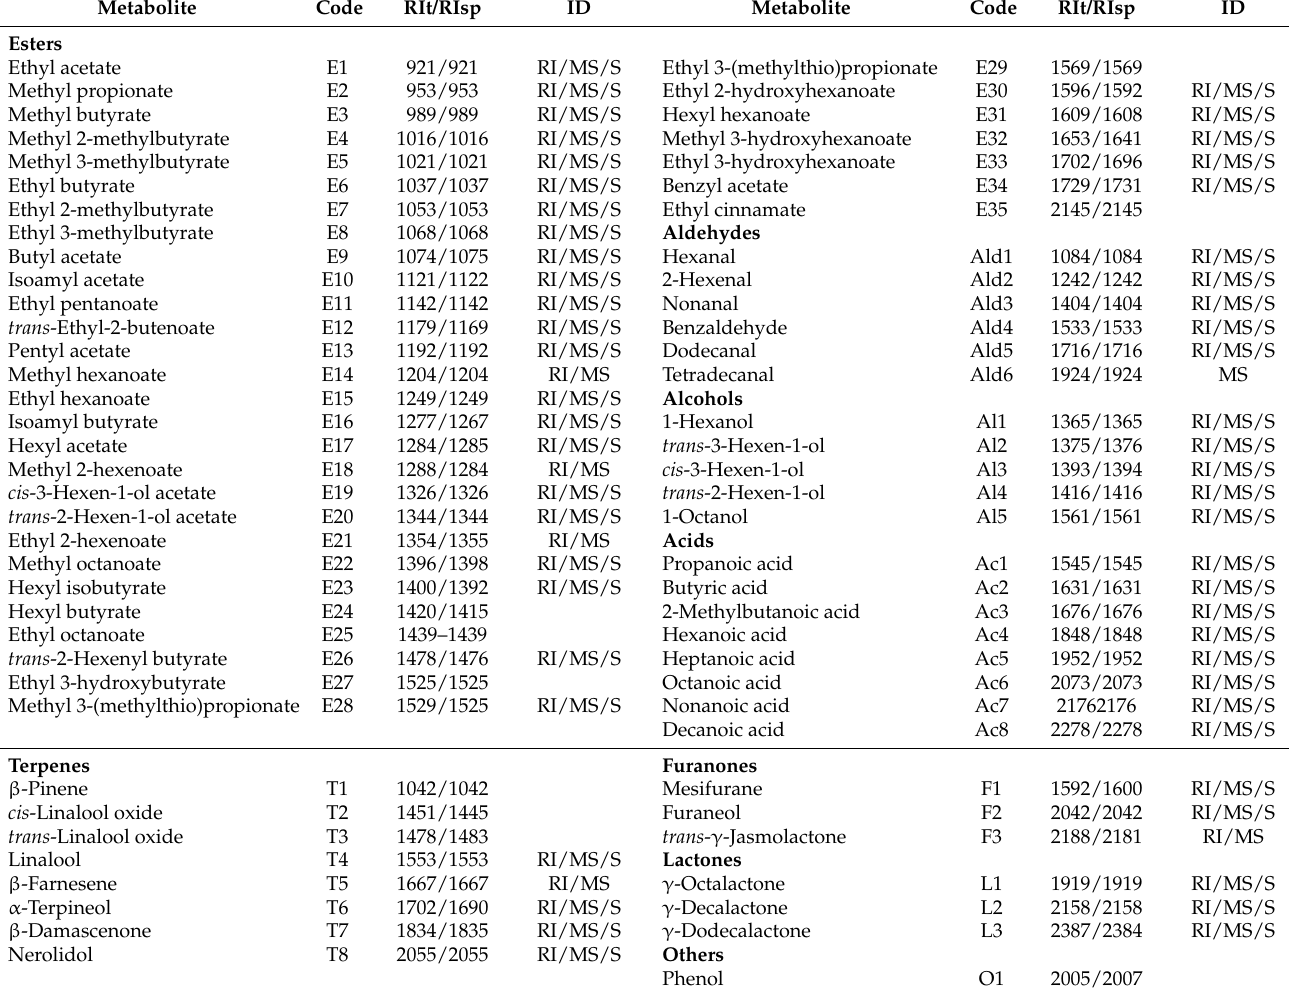
Table 1. Volatile metabolites detected in Sabrina and Elide strawberry cultivars and their identification